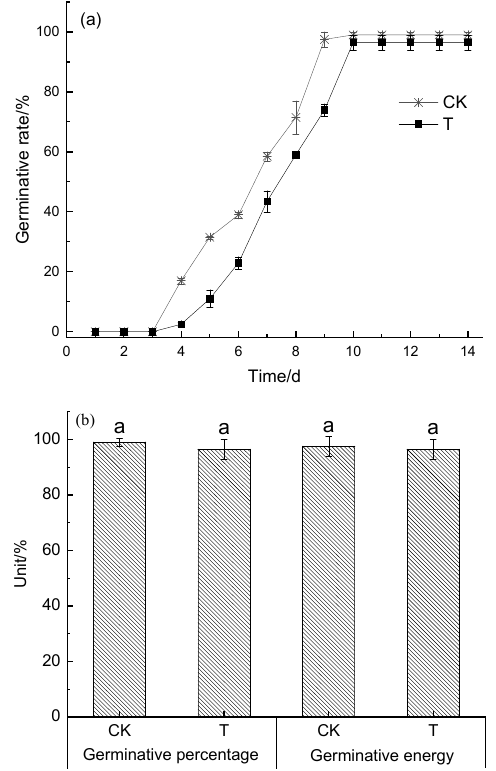
Figure 1. The effect of PBAT-BMF extract on tobacco seed germination, ( a ) germinative rate ( b ) germinative energy and germinative percentage (a: p < 0.05 statistical significance).